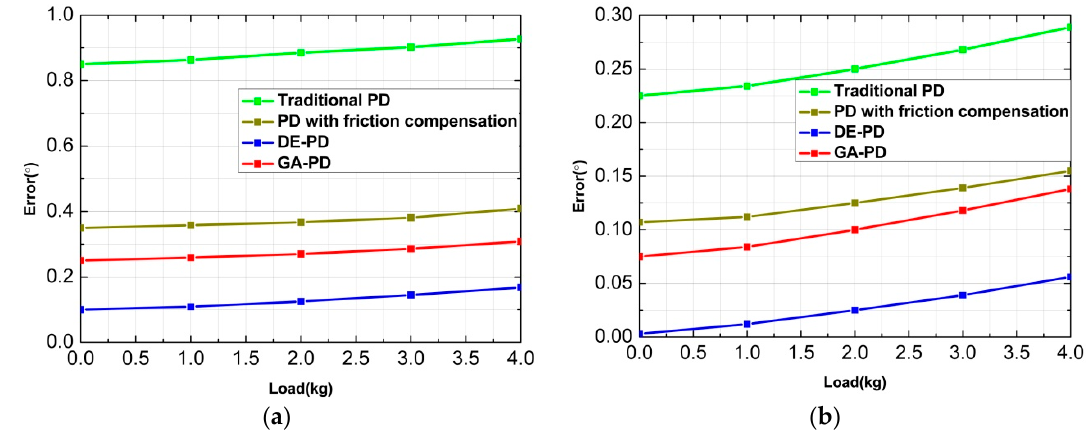
Figure 17. Angle errors under different loads. ( a ) Position tracking error; ( b ) positioning error.